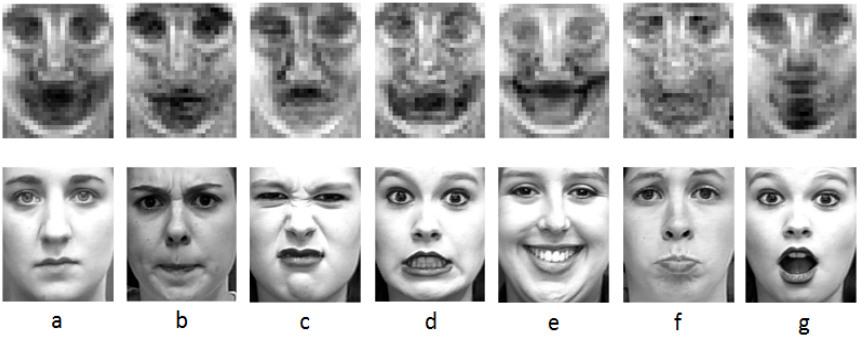
Figure 2. The salient areas of the six expressions. ( a ) Salient areas of all expressions and neutral; ( b ) Salient areas of anger; ( c ) Salient areas of disgust; ( d ) Salient areas of fear; ( e ) Salient areas of happy; ( f ) Salient areas of sad; ( g ) Salient areas of